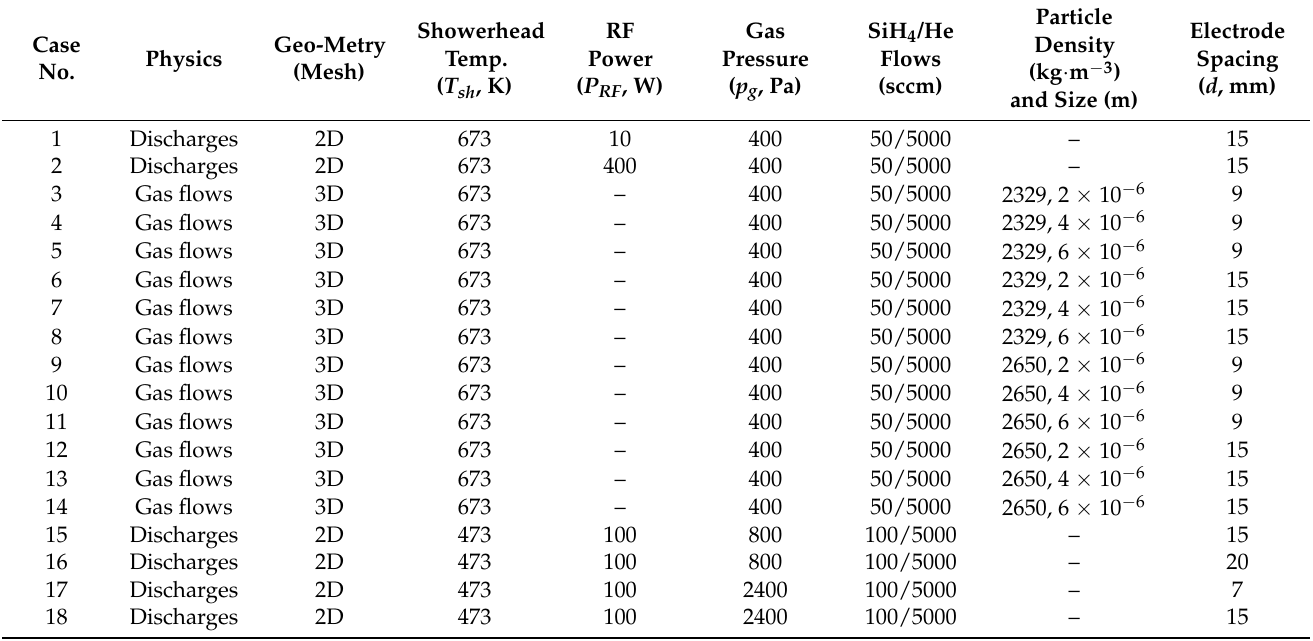
Table 1. List of cases considered in this study. We analyzed particle transport phenomena using a three-dimensional complex geometry, whereas SiH 4 /He discharges were simulated in a two-dimensional simplified